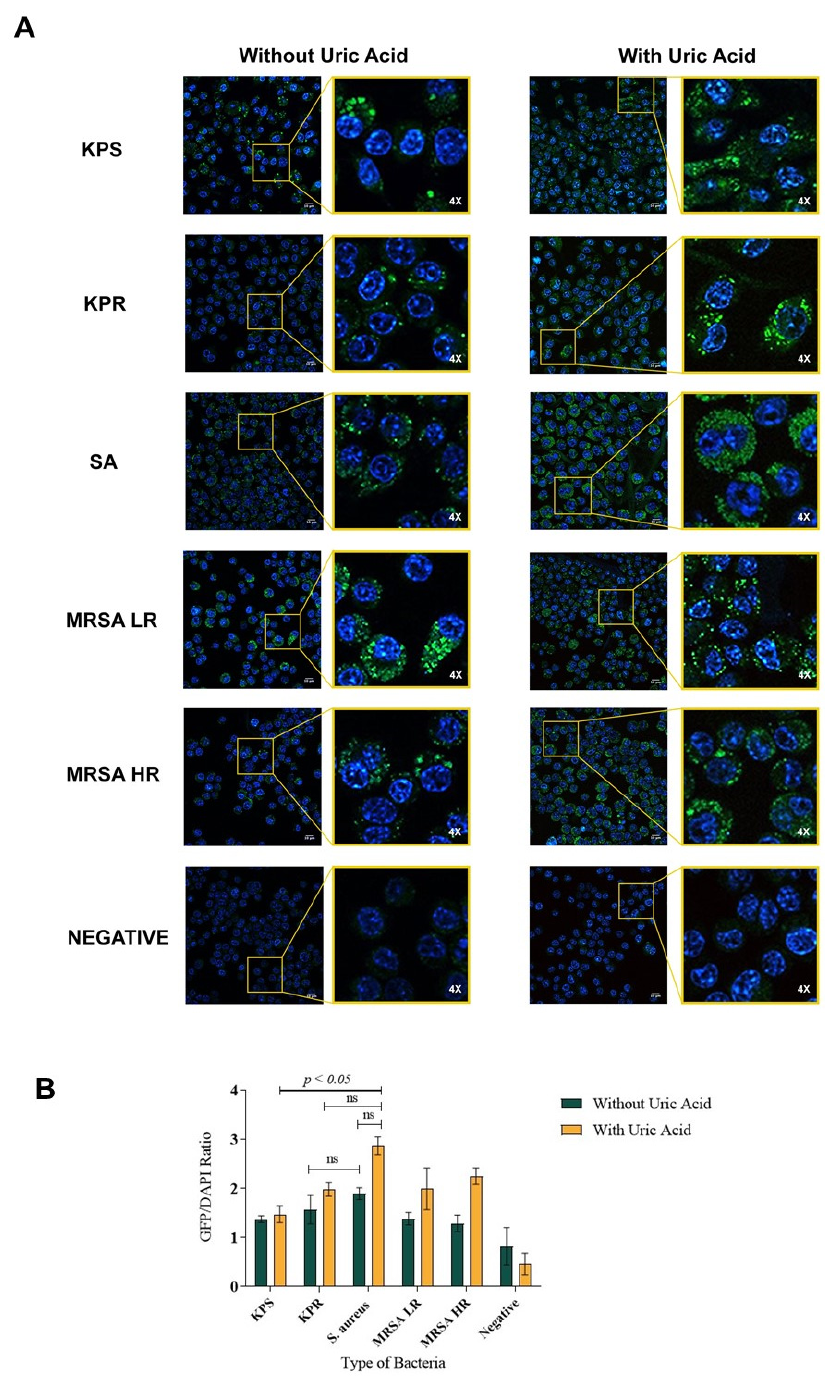
Figure 1. Soluble uric acid enhances autophagy flux in infected murine macrophages. Representative images of murine RAW264.7 macrophages infected with di ff erent strains of Staphylococcus aureus or Klebsiella pneumoniae and stained with autophagy flux detection kit. ( A ) Macrophages infected with bacteria only and macrophages infected with bacteria and soluble uric acid (19 mg / dL). DAPI-stained nuclei are shown in blue color, while active autophagy vacuoles are the green puncta. ( B ) Quantitative image analysis was performed using the intensity of GFP-to-DAPI ratio calculated in murine RAW264.7 macrophages induced by di ff erent strains of S. aureus and K. pneumoniae in presence and absence of uric acid stimulation (19 mg / dL). The inset is magnification of a representative image showing autophagy puncta (green) and nucleus DAPI staining (blue). The data represent the mean of three independent experiments with error bars depicting the standard error of the mean. The images were analyzed